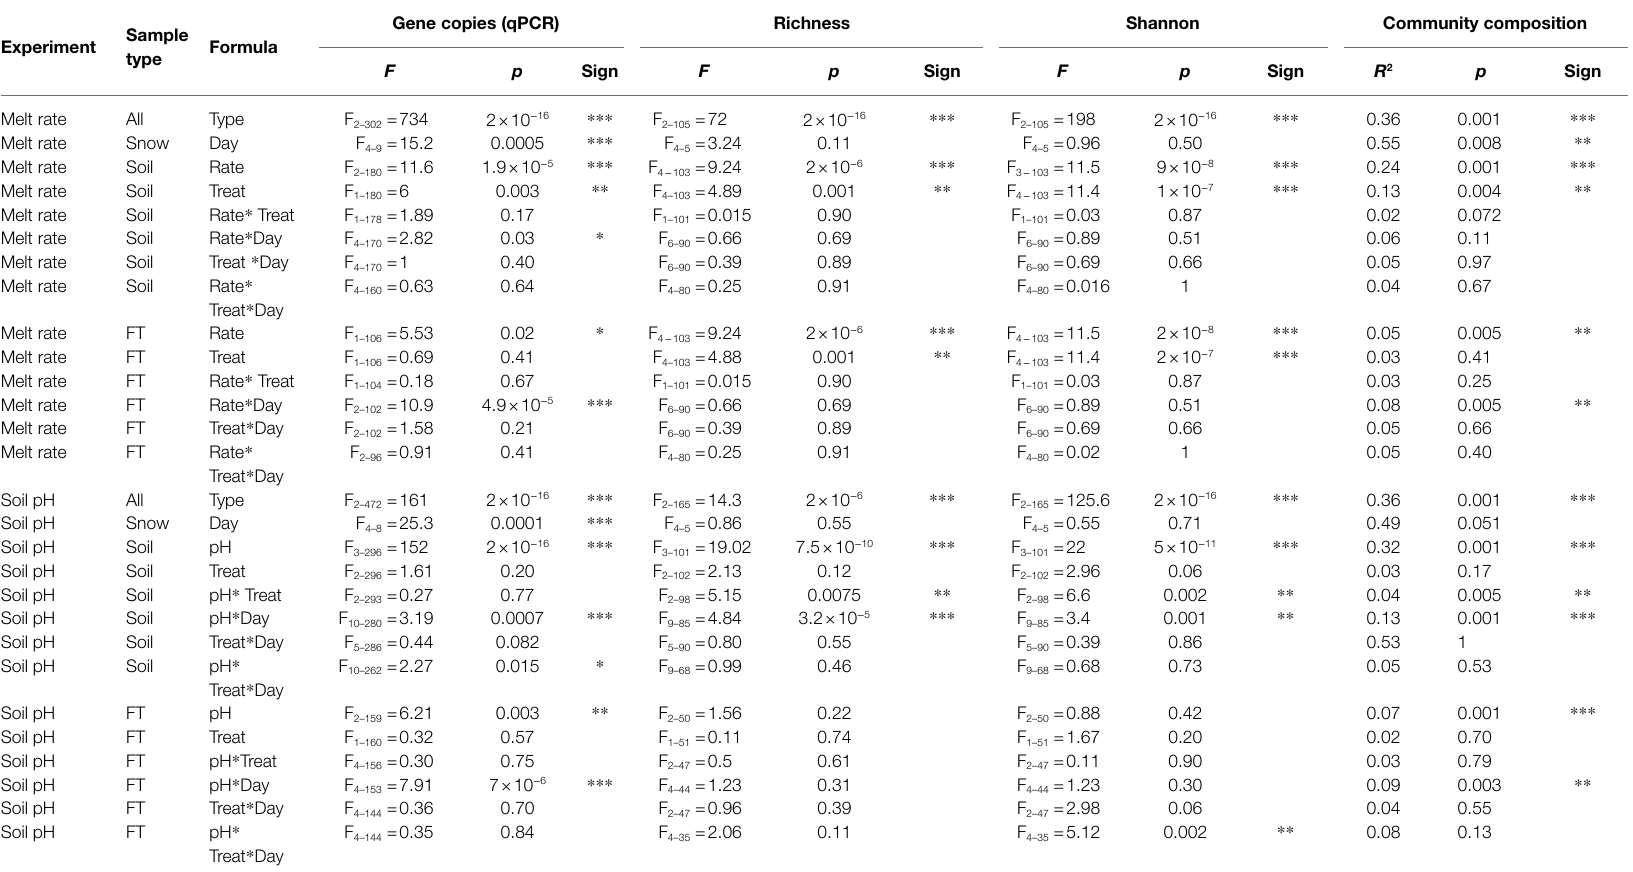
TABLE 1 | Results of the ANOVA tests on gene copy numbers (qPCR), richness and Shannon diversity and results of the adonis tests on Bray–Curtis community